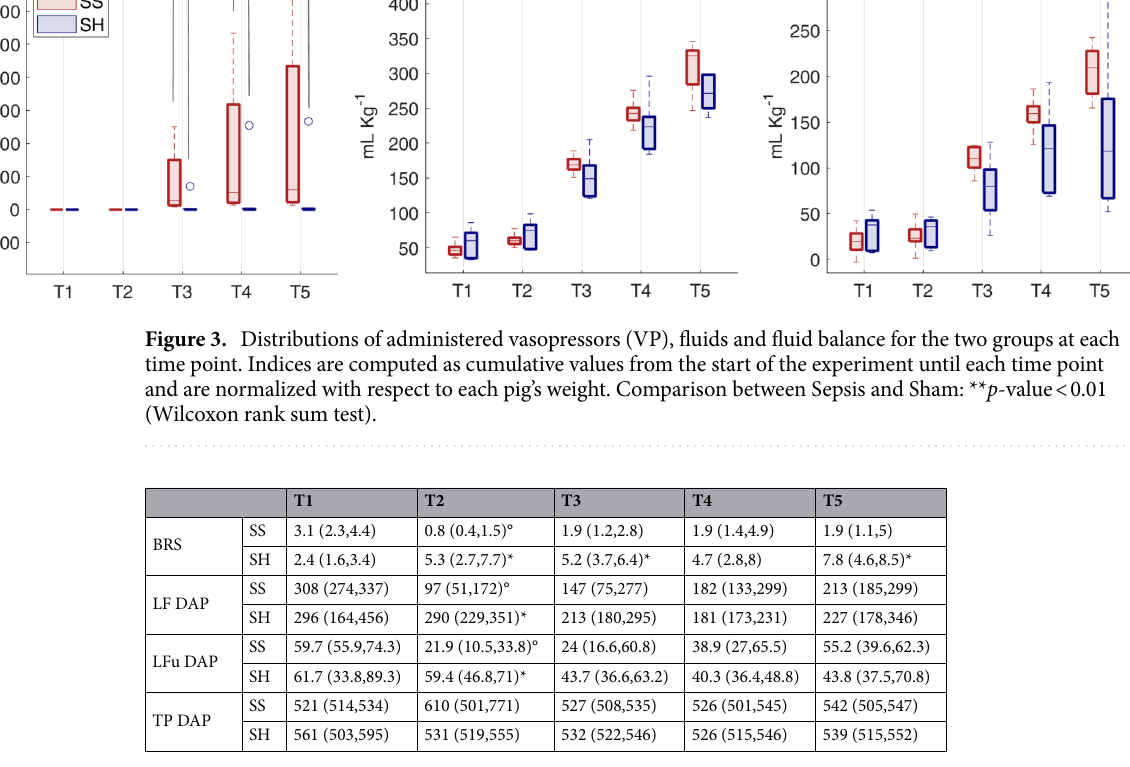
Table 2. Medians (25–75th percentiles) values of cardiac baroreflex sensitivity and power spectral indices of diastolic arterial pressure time series computed at each time point for the two groups (septic pigs SS n = 9, sham pigs SH n = 7). BRS = baroreflex sensitivity [ms/mmHg], LF DAP = low frequency power of diastolic blood pressure [a.u.], LFu DAP = normalized low frequency power of diastolic blood pressure [%], TP DAP = total power of diastolic blood pressure [a.u.]. Comparison between Sepsis and Sham: * p -value < 0.05 (Wilcoxon rank sum test). Wilcoxon signed test: ° p -value < 0.05 with respect to T1 (Friedman test p -value < 0.05).